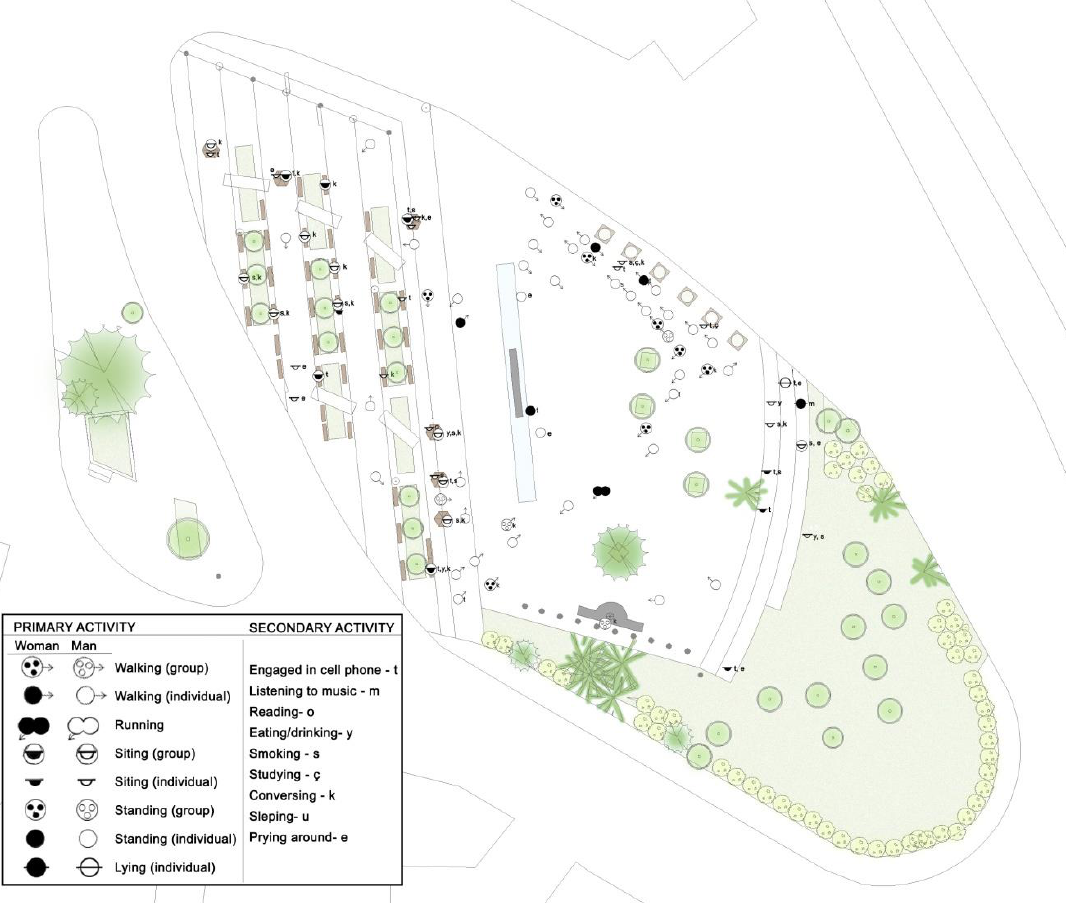
Figure 3 Primary and secondary activities, including their attached symbols, specifying male and female users, used for recording activities in Küçükçekmece square within one observation